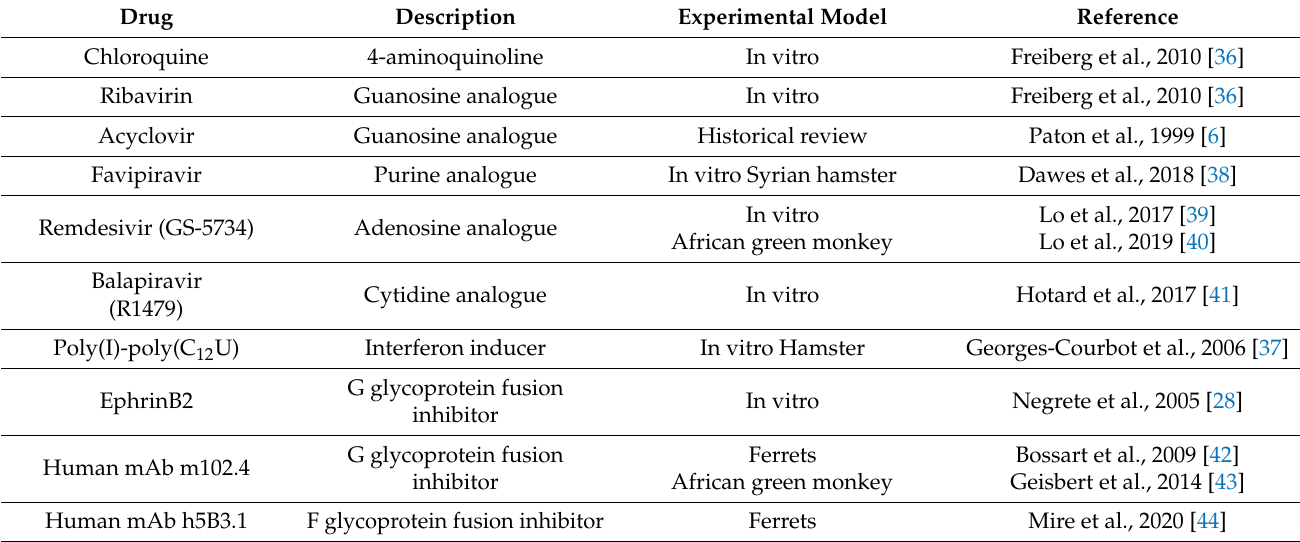
Table 2. Summary of drugs with potential antiviral activity against Nipah virus. Legend—mAb: monoclonal antibody.